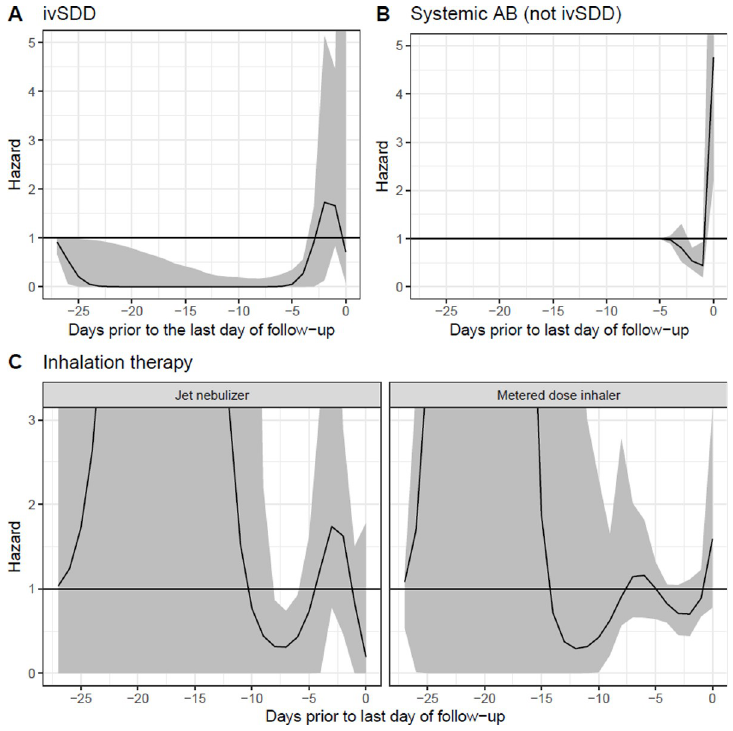
Fig 4. Daily hazard ratios attributed to past values of the covariates assessed with a weighted cumulative effects approach in the multivariate Cox regression model: (A) ivSDD, (B) ivAB, (C) Jet nebulizer (compared to no inhalation therapy) and metered dose inhalers (MDI) (compared to no inhalation therapy) . The curve shows the estimated risk attributed to exposures on each day prior to the last day of follow-up (i.e., the event date or the censoring date) and the grey ribbon shows the 95% confidence interval. A value of one indicates no effect of the exposure at that time. At times where the grey ribbon includes one, the effect is considered to be statistically